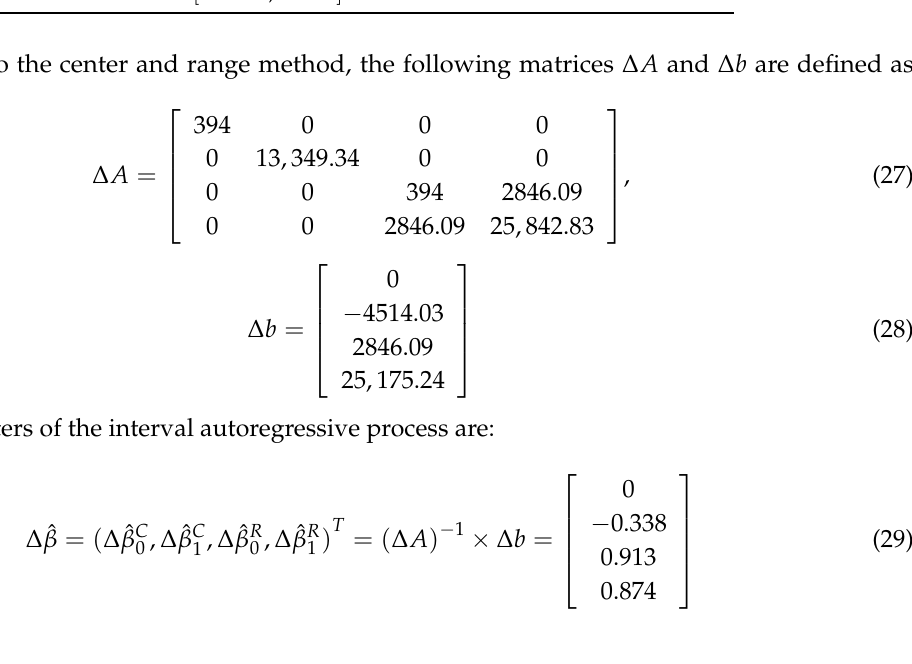
Table 3. Midpoint–radius form of interval.